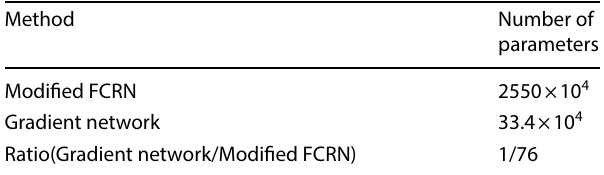
Table 5 Comparison of the number of parameters